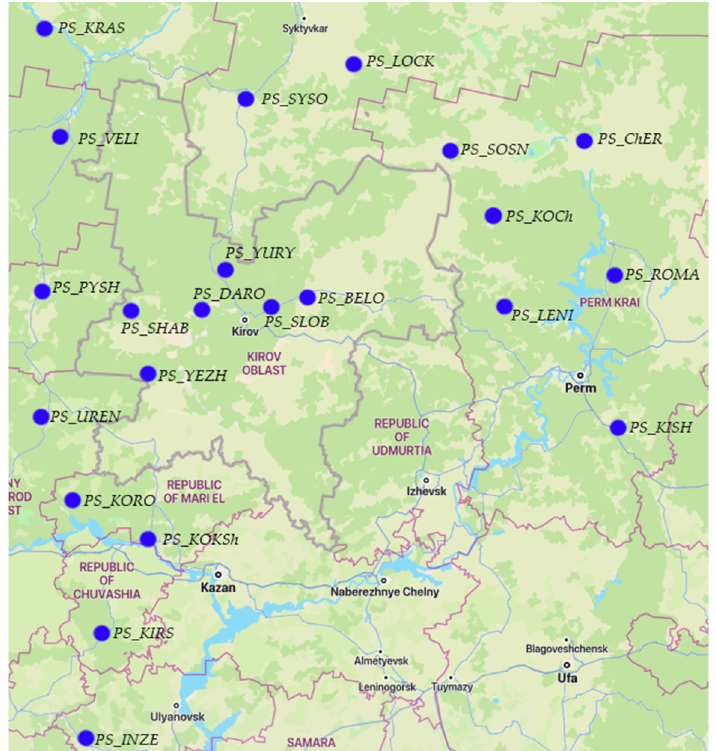
Figure 1. Schematic map of the location of the studied populations of P. sylvestris : PS_KOCh—